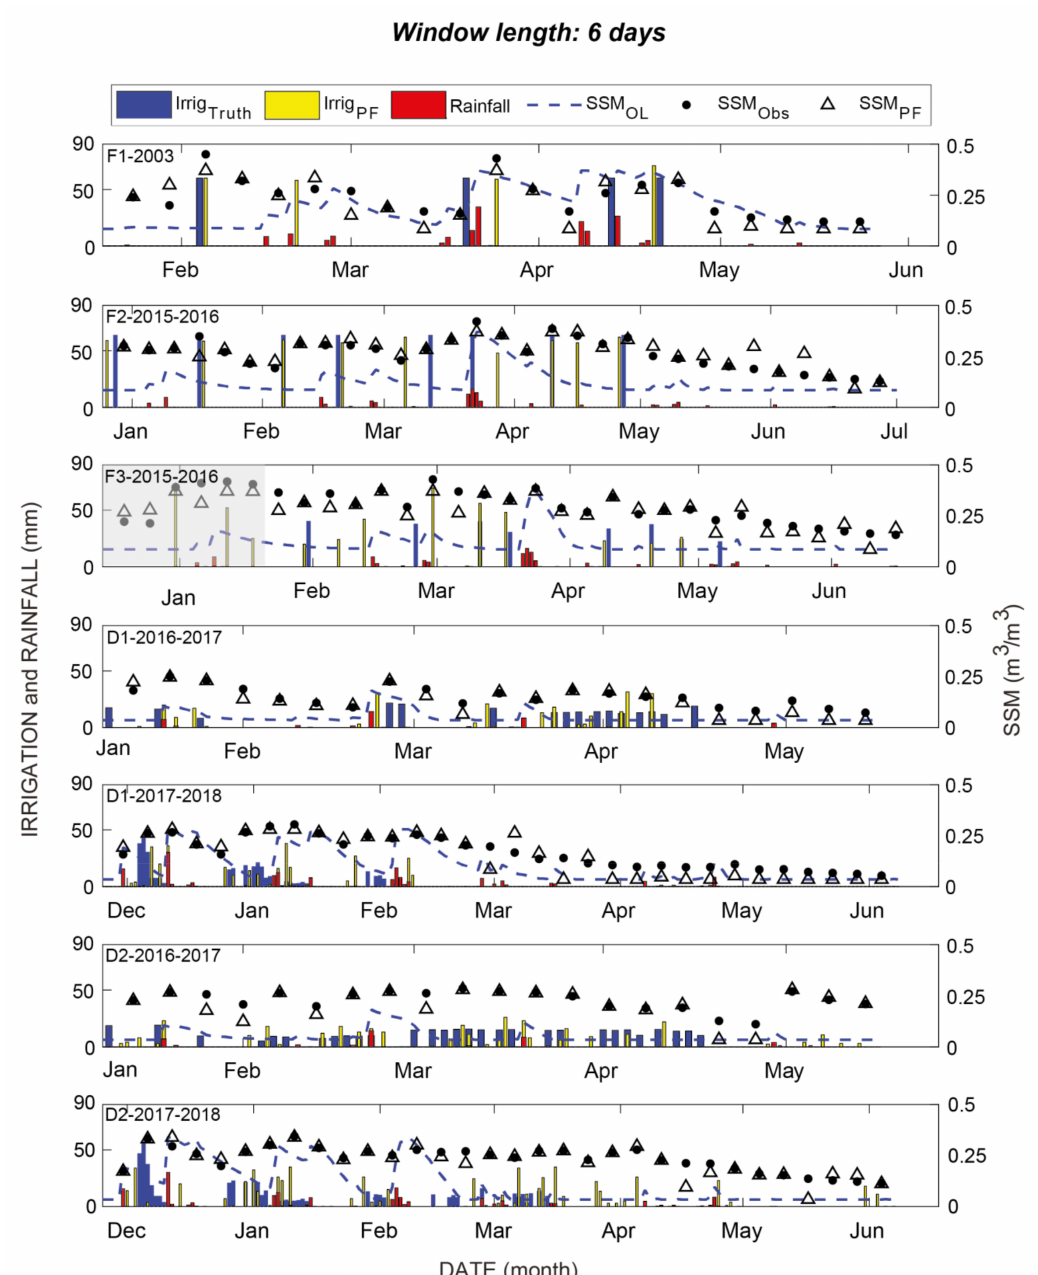
Figure 3. Time series of the estimated irrigation amounts and timing (Irrig PF ), the actual irrigation (Irrig Truth ) and the measured rainfall. Time series of the assimilated (SSM PF ), measured (SSMobs) and the open loop (SSM OL ) SSM over the irrigated fields (D1, D2, F1–F3) for all the seasons for a window length of 6 days are also